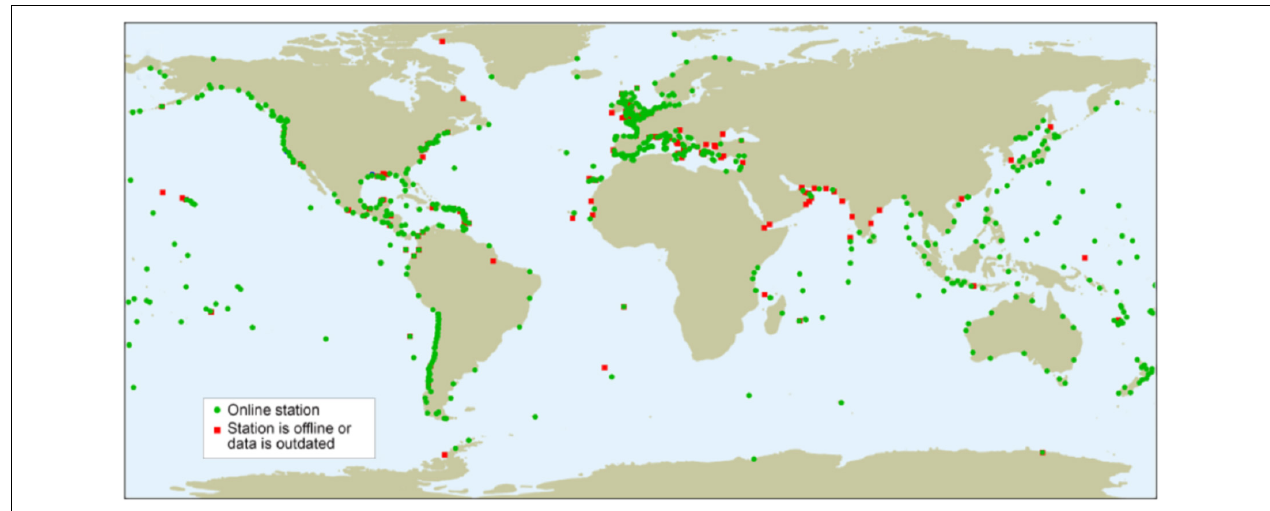
FIGURE 6 | Coverage of available real-time coastal sea-level data (green dots) as of February 2019. (Red dots indicate data outages.) Note large gaps around the world where data is not available in real time. Source: IOC/UNESCO Sea Level Station Monitoring Facility.